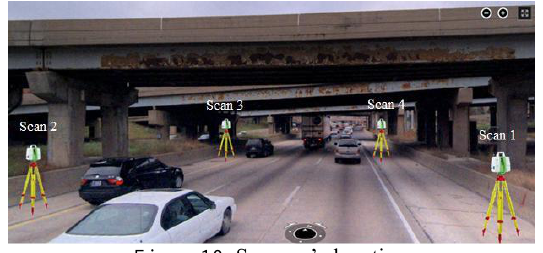
Figure 10. Scanner’s location